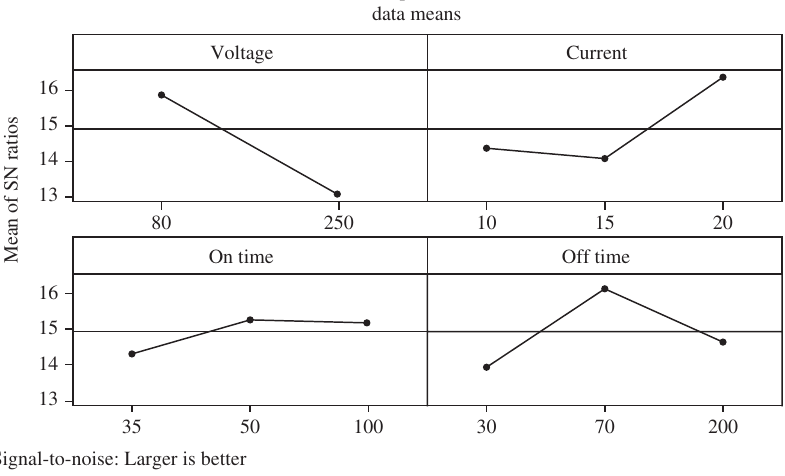
Figure 1: Effects of the input parameters of EDM on MRR in the machining of Al/5%Al